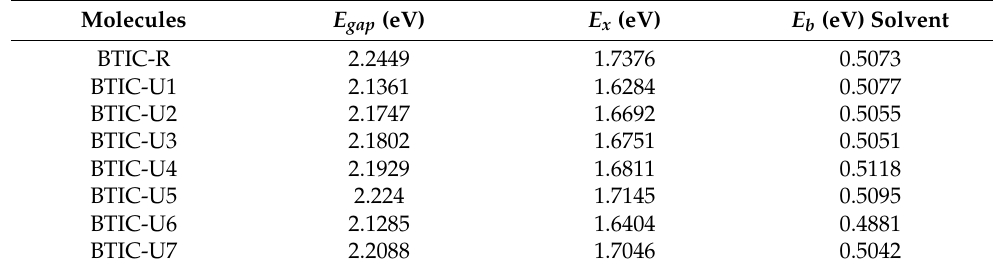
Table 10. E gap , Ex , and E b (chloroform solvent) of BTIC-R and BTIC-U1 to BTIC-U7 molecules.